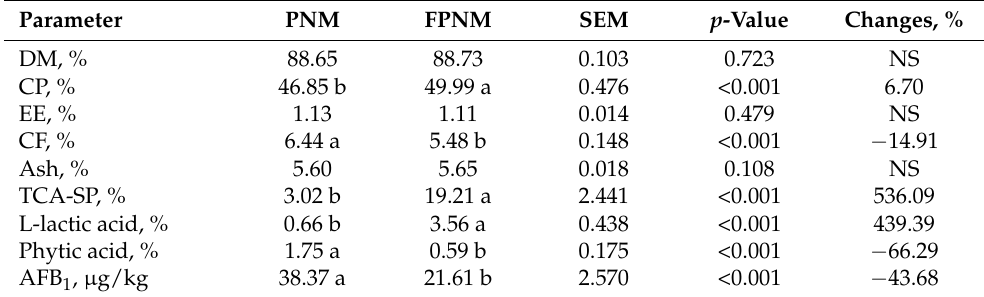
Table 3. Effects of solid-state fermentation on the chemical composition of PNM and FPNM (dry matter basis, n = 3) 1 .